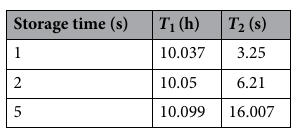
Table 5. Optimum solutions for values of T 1 and T 2